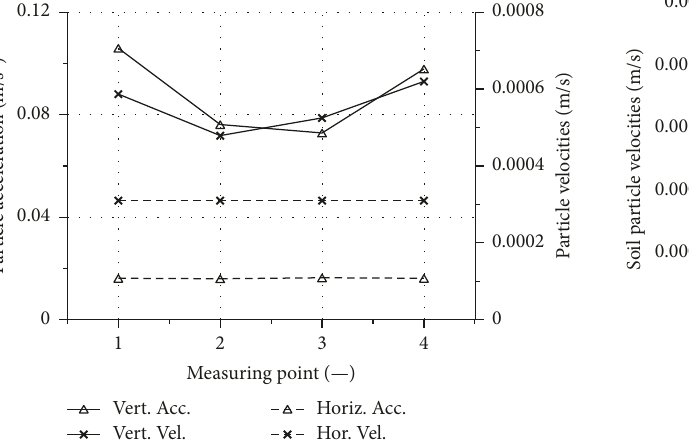
Figure 11: Soil vertical velocity with (dashed) and without (solid line) a wave